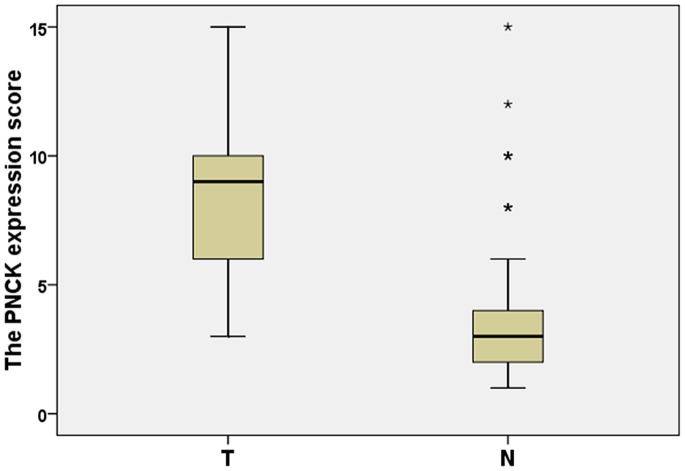
Increased protein expression of PNCK in ccRCC.The relative protein expression of PNCK in ccRCC tumor (T) tissue samples was higher than that in the paired adjacent normal (N) tissue samples (n = 76, P<0.001). The bottom and top of the box are the lower and upper quartiles, and the band near the middle of the box is the median. The ends of the whiskers represent the 2.5th percentile and the 97.5th percentile. Four black stars represent the special value outliers.